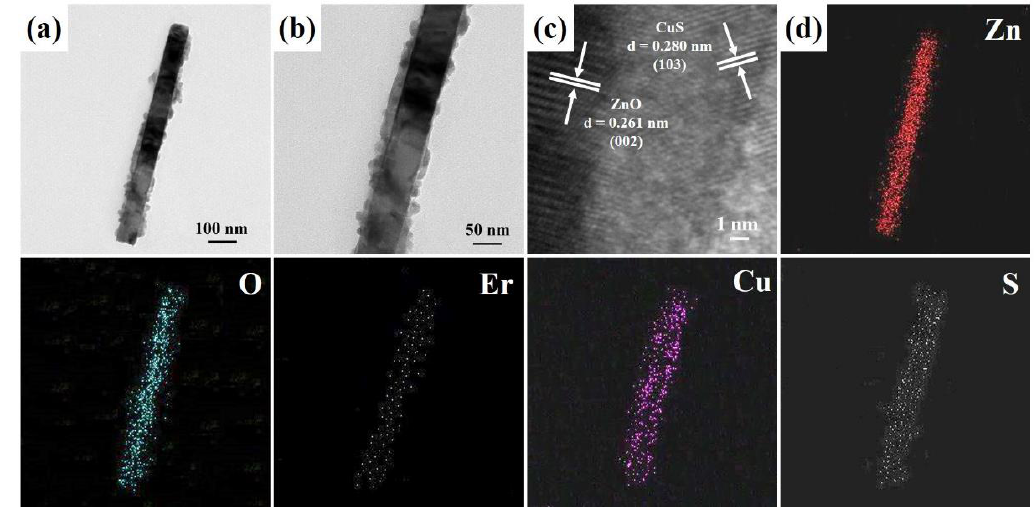
Figure 3. ( a , b ) FETEM, ( c ) HRTEM, and ( d ) EDS mapping images of an Er-doped ZnO/CuS core-shell nanowire (10 mM CuS precursor).